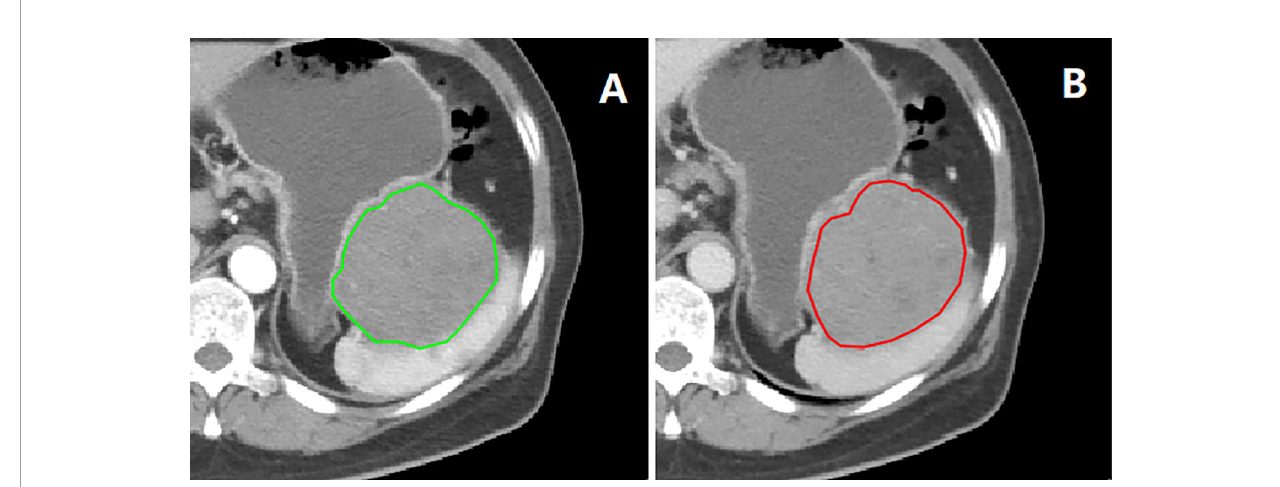
FIGURE 1 | Example of tumor delineation and segmentation. (A) arterial phase; (B) venous